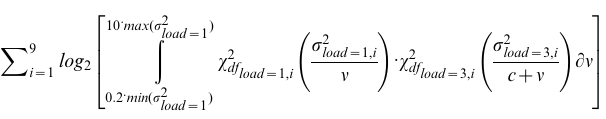
Figure S1 Related to Figure 4; Memory load effects on systematic error. (A) Memory load only affected the divergence of the error field. (B) Proportional recall bias in center of screen (CS) coordinates (in blue) when the memory load is one. (C) Proportional recall bias in CS (in blue) and center of the memory items’ configuration (CM) coordinates (in red) when the memory load is three. Target azimuth and elevation, in CS coordinates, was overestimated both when the memory load was one and three. In addition, when the memory load was three, participants underestimated both target azimuth and elevation in CM coordinates. trans - translation, diverge - divergence, rota_cw - clockwise rotation. **p , 0.01. (TIF) Figure S2 Related to Figure 5; Probing procedure effects on the systematic error. (A) Probing procedure only affected the divergence of the error field. (B) Proportional systematic bias in screen (CS) coordinates along azimuth and elevation, and center of memory items’ configuration (CM) coordinates along azimuth and elevation following location (in blue) and color-probes (in red). Target azimuth, in CS coordinates, was overestimated whether the probe was location or color. Along the azimuth, significantly smaller displacements of the recalled target locations towards the CM were observed following location than color-probes. trans - translation, diverge - divergence, rota_cw - clockwise rotation, azim - azimuth, elev - elevation. *p , 0.05. (TIF) Figure S3 Related to Figure 5; Probing procedure effects on spatial recall in mixed-probe blocks. (A) The error standard deviation is shown as a function of target azimuth, following location (in blue) and color-probes (in red), and (B) as a function of target elevation. The variable error was smaller following location than color-probes. This difference was largest for targets between the center and the boundaries of the display. (C) Following location-probes, participants underestimated the target distance from the center of the screen less prominently than (D) following color-probes. Figure S4 Related to Figure 5; Probing procedure effects on the systematic error in mixed-probe blocks. (A) Probing procedure only affected the divergence of the error field. (B) The proportional systematic bias in screen (CS) and center of memory items’ configuration (CM) coordinates, along azimuth and elevation, is shown following location (in blue) and color-probes (in red). Along azimuth as well as elevation, significantly smaller displacements of the recalled target locations towards the CM were observed following the location than the color-probe. trans - translation, diverge - divergence, rota_cw - clockwise rotation, azim - azimuth, elev - elevation. **p , 0.01, ***p , 0.001. (TIF) Data S1 Related to Results, Statistical analysis of experiments 2, 4 and